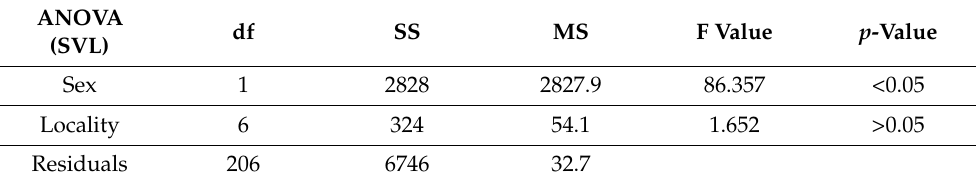
All 29 sampled individuals were successfully genotyped using our microsatellites panel (see Table S5 for details). However, only seven out of the eight loci were successfully obtained. In the sPCA (Figure 7), all the islands appear distinct from each other with the sole exception of Elba and Cerboli, which show full